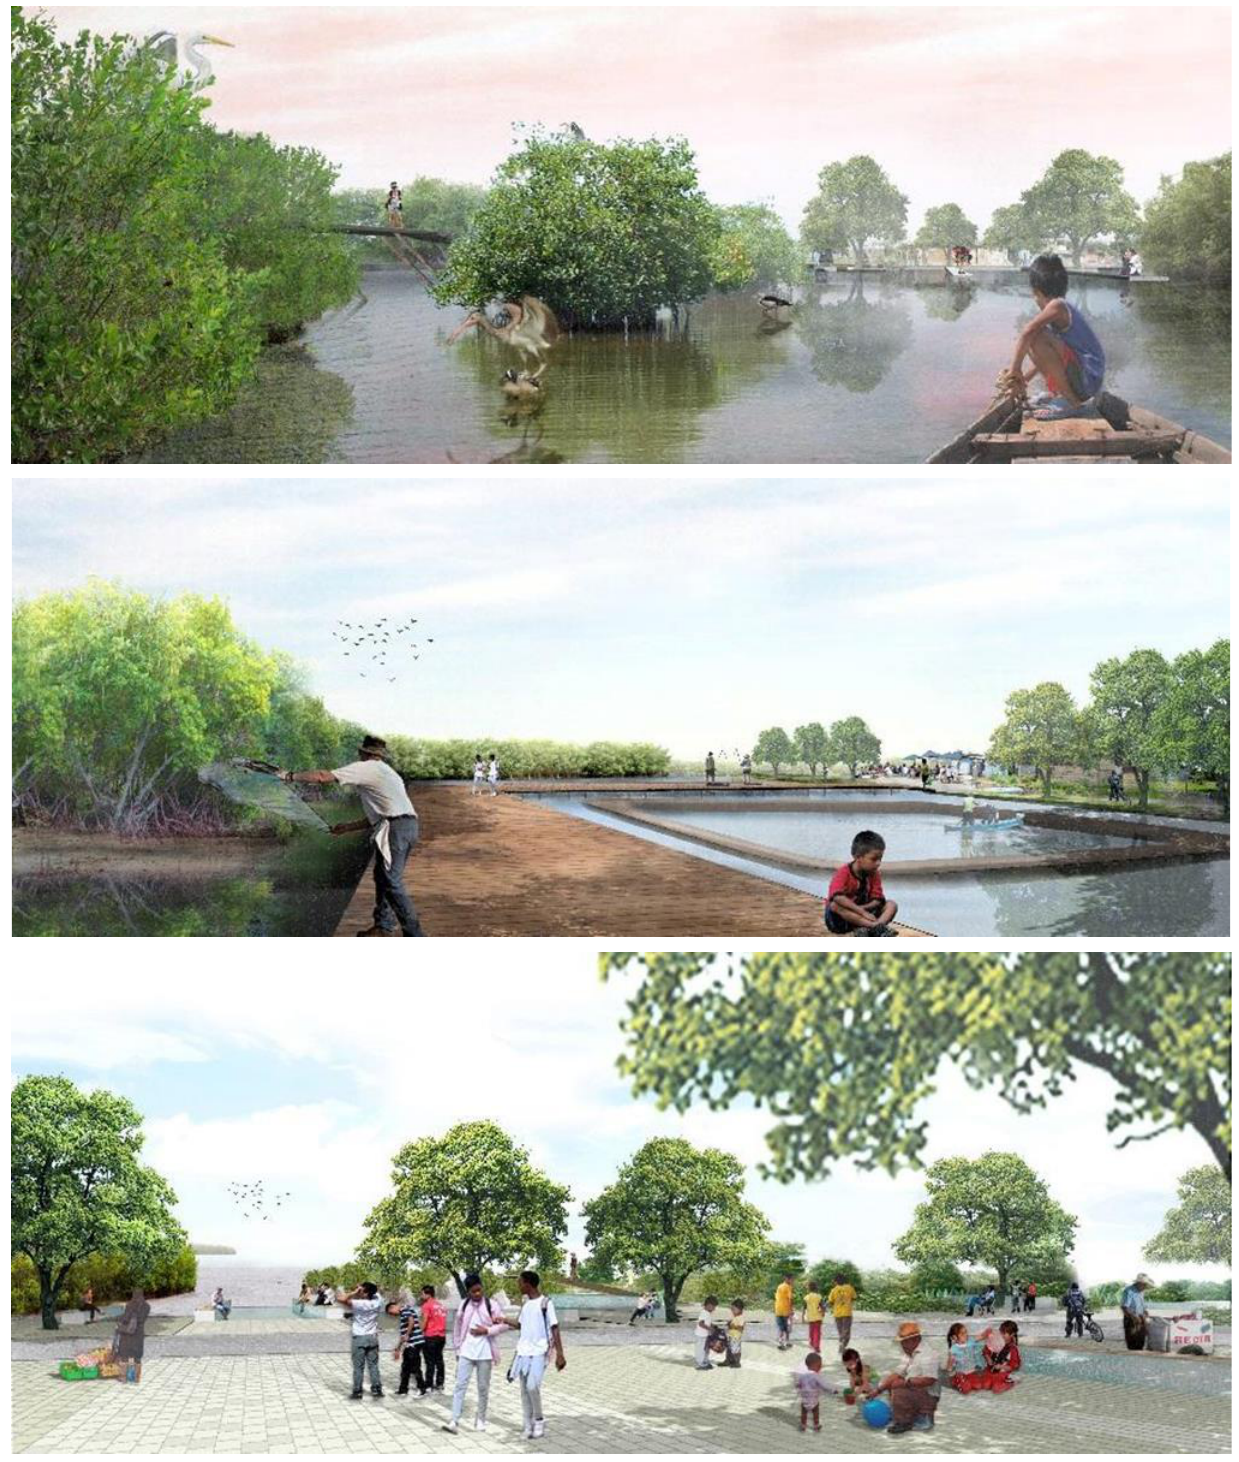
Figure 10. Productive Landscape and social life © Aubrey Jahelka, Shuwen Ye.